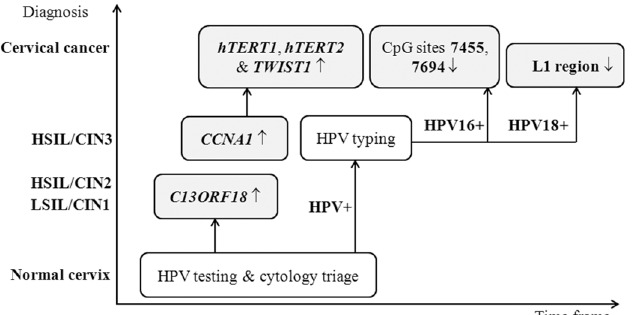
Fig 1. Suggested algorithm for DNA methylation potential biomarkers use in clinical practice. LSIL, low-grade squamous cell intraepithelial lesion; HSIL, high-grade squamous cell intraepithelial lesion; CIN, cervical intraepithelial neoplasia; " , hypermethylated; # , hypomethylated.